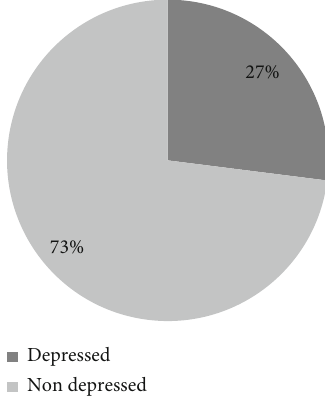
Figure 1: Prevalence of depression among respondents ( n = 371 ). Table 6: Test of multicollinearity of di ff erent independent variables related to